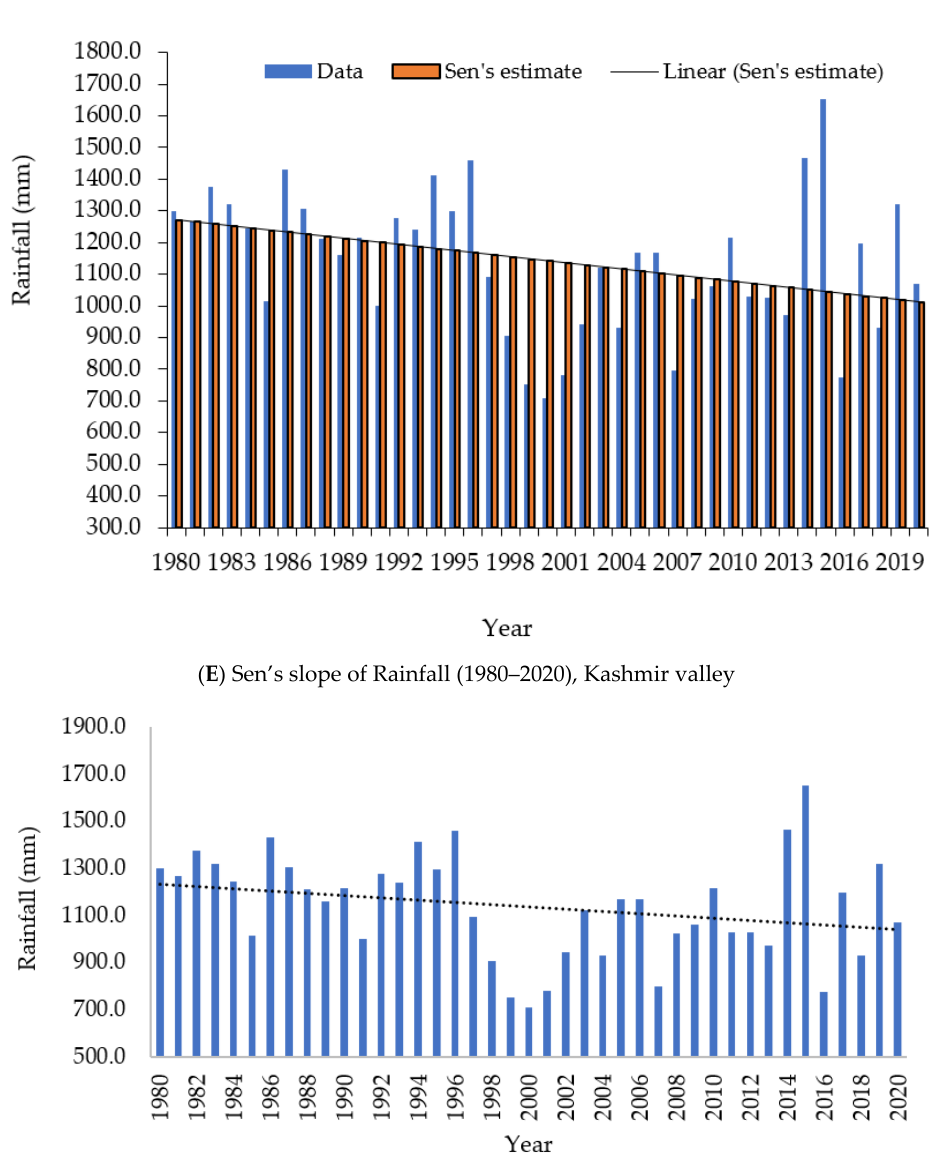
Figure 8. Descriptive statistics of weather parameters viz., Maximum and Minimum temperature and rainfall of location Kashmir valley